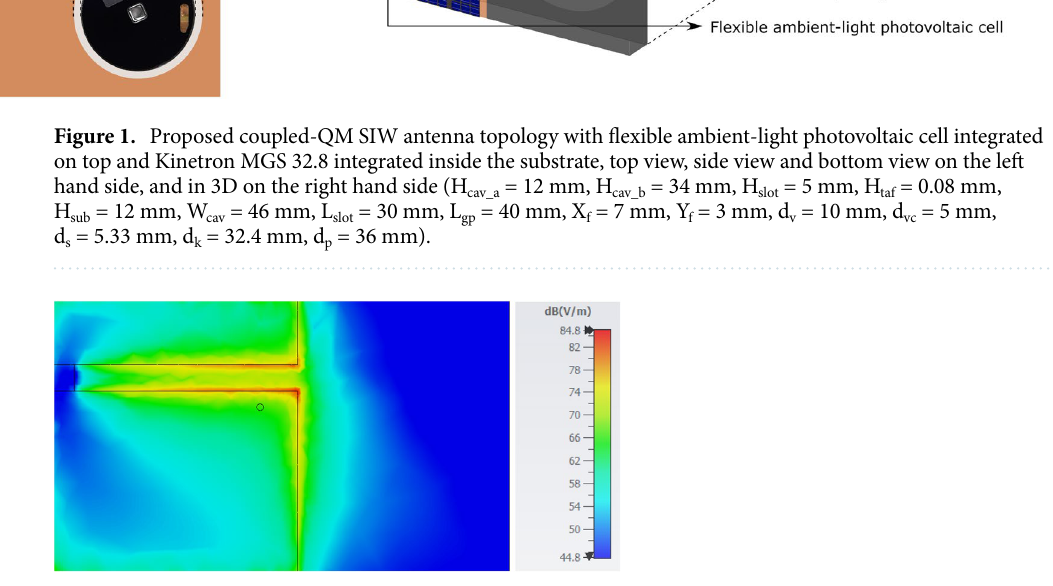
Figure 2. Simulated electric field distribution observed inside the resonant cavities at 2.45 GHz in